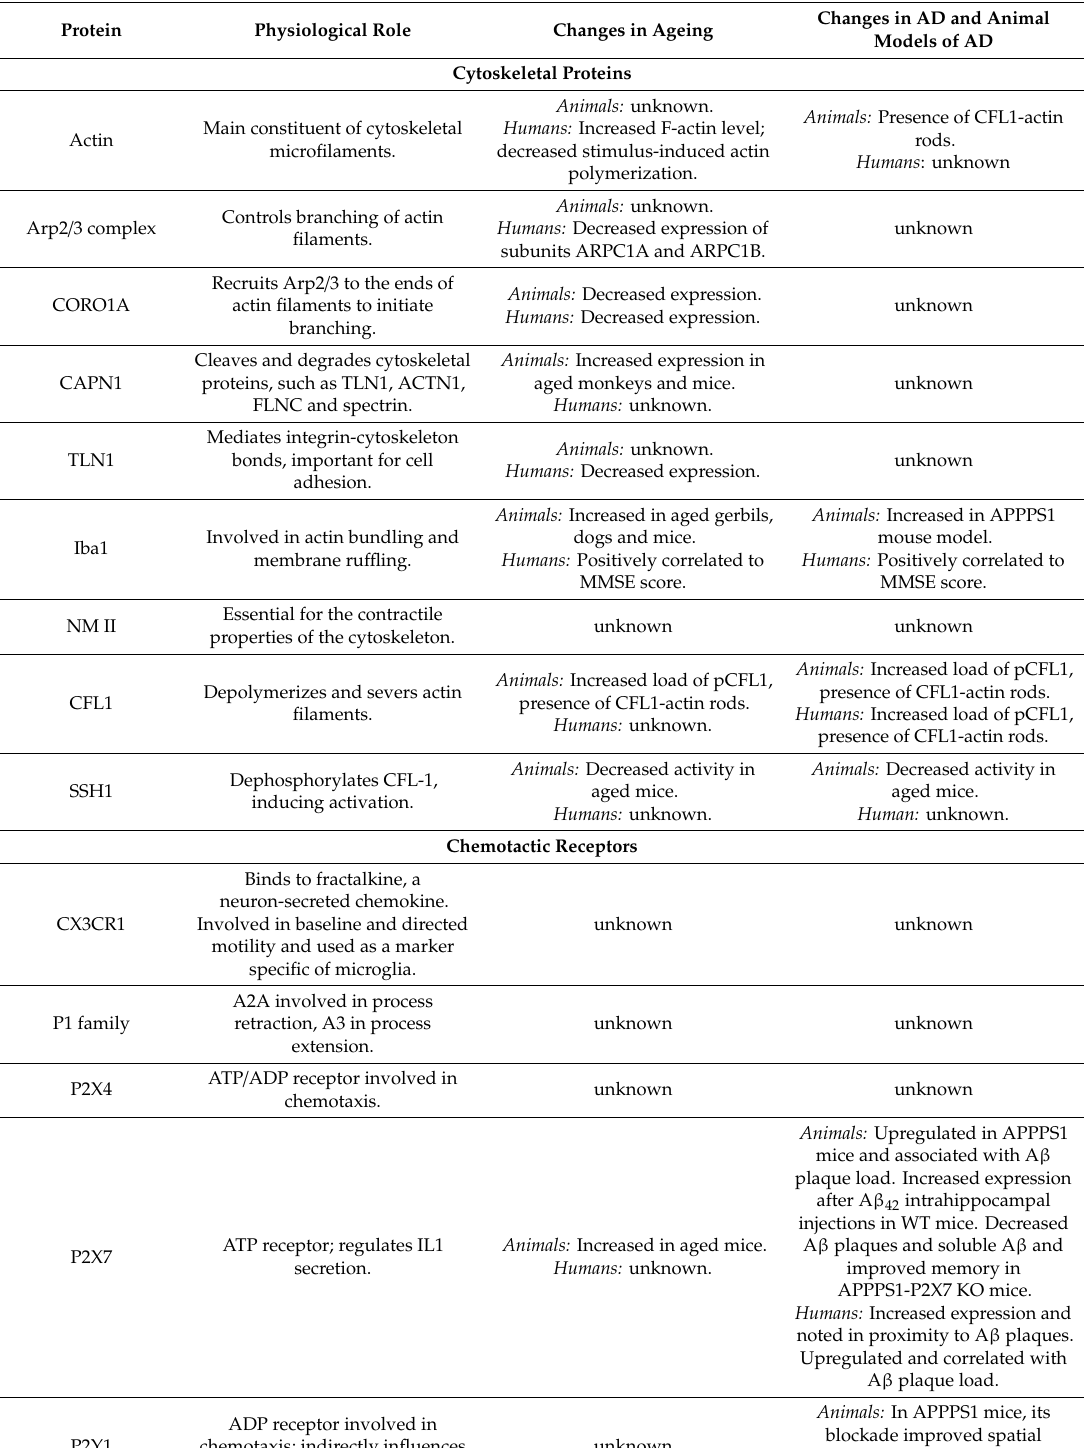
Table 1. Summary of the most relevant proteins involved in microglial motility: Physiological function and changes in ageing and Alzheimer’s disease highlighting the gaps in our current knowledge. Changes in AD and Animal Protein Physiological Role Changes in Ageing Models of AD Cytoskeletal